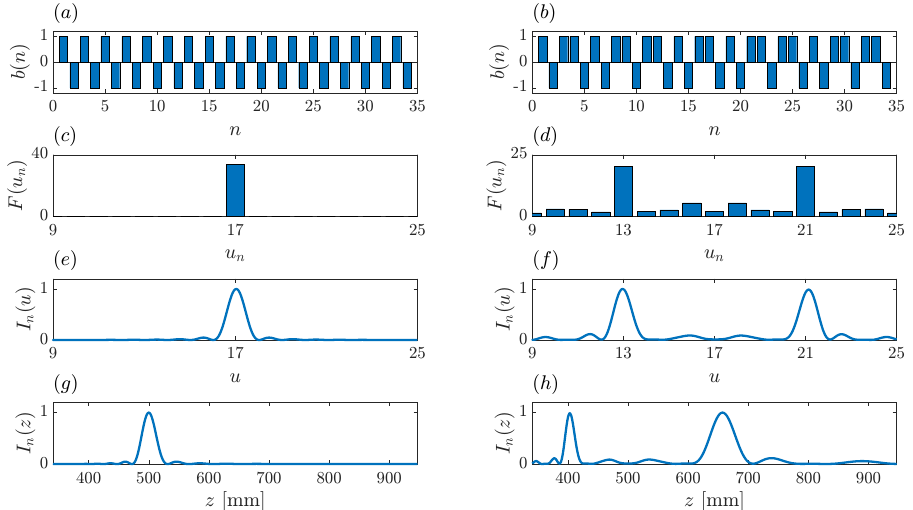
Figure 2. Fourier transforms on binary sequences for a Fresnel ZP ( a , c , e , g ) and a Fibonacci ZP ( b , d , f , h ). Binary sequences: ( a , b ). Focusing profile sequences: ( c , d ). Normalized focusing profile as a function of u : ( e , f ). Normalized focusing profile as a function of z : ( g , h ). The F ( n ) sequence is computed as the FFT of the b ( n ) sequence. Focusing profiles are computed using the Rayleigh-Sommerfeld diffraction